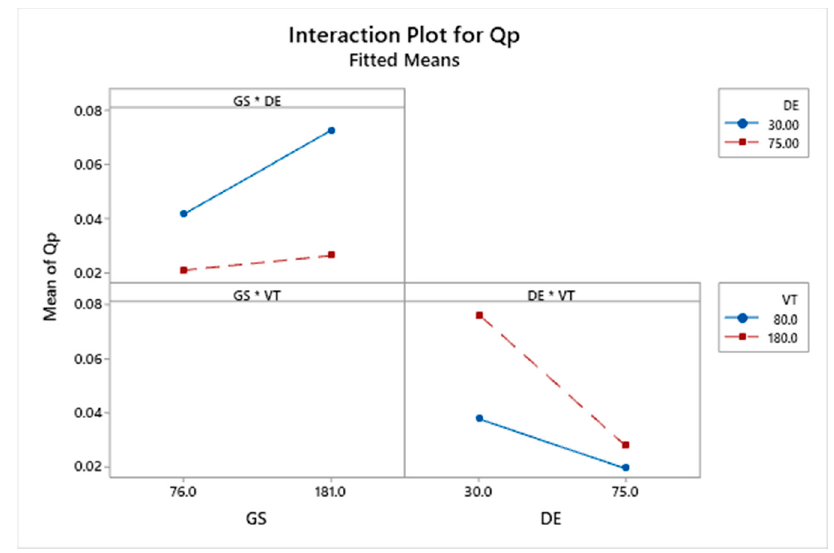
Figure 10. Interaction plot for tool wear Qp.